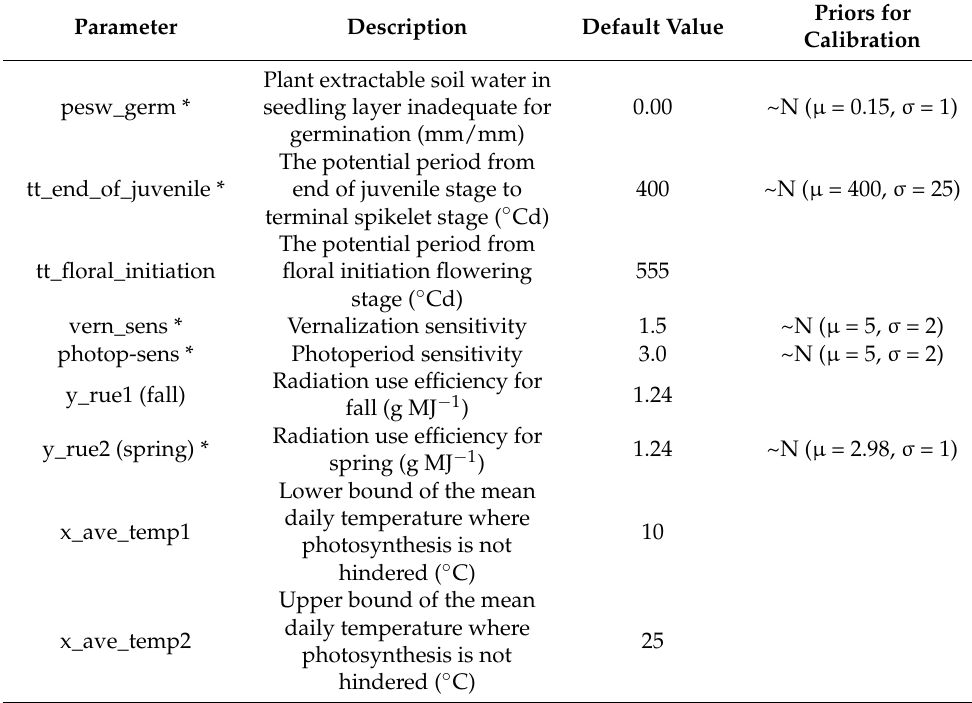
Priors for Calibration 0.00 ~N ( µ = 0.15, σ = 1)